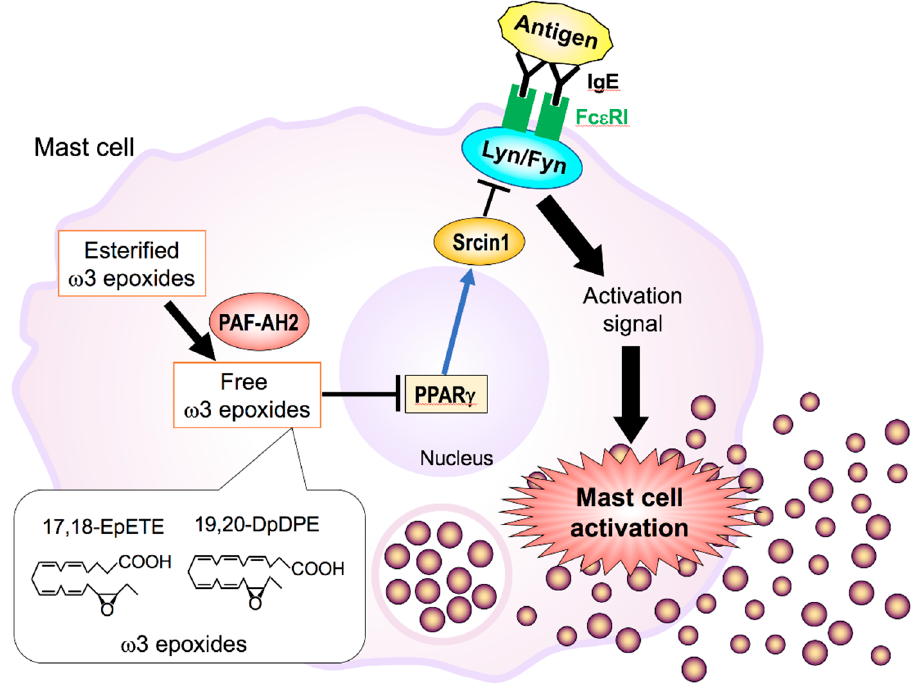
Figure 5. The role of PAF-AH2 in mast cell activation by producing ω 3 epoxides. PAF-AH2 constitutively hydrolyzes ω 3 epoxide-esterified phospholipids in cell membranes to liberate ω 3 epoxides. These unique ω 3 PUFA metabolites attenuate PPAR γ signaling and downregulate Srcin1, which blocks activation of the Src family kinases Fyn and Lyn, thereby augmenting Fc ε RI signaling.